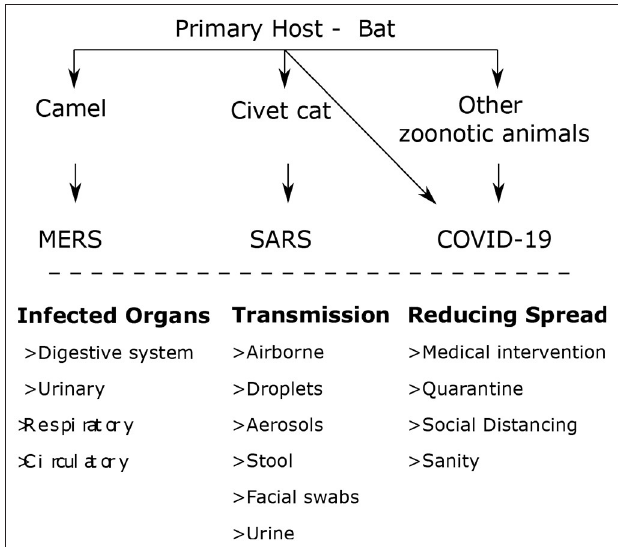
FIGURE 1 | Transmission of the SARS-COV (Darapaneni et al., 2020).